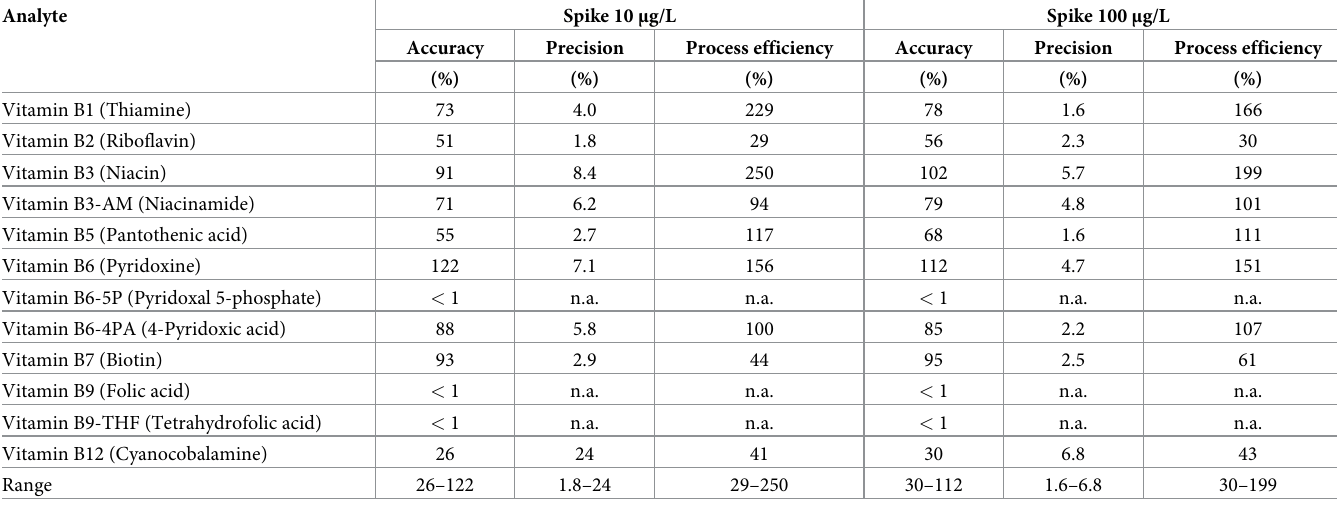
Table 3. Validation characteristics of the method using TCA as a precipitating